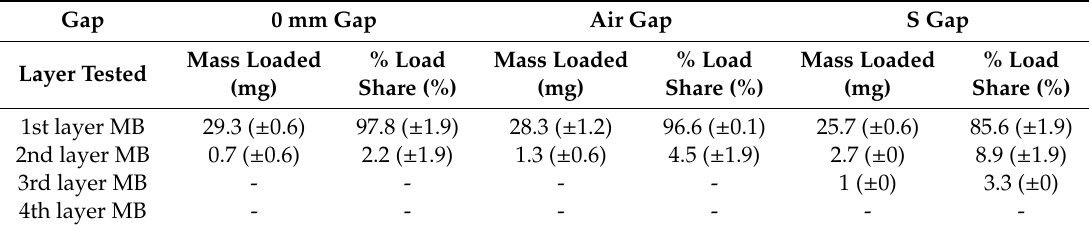
Table 4. Loaded mass for each layer for 4-layer constructions.